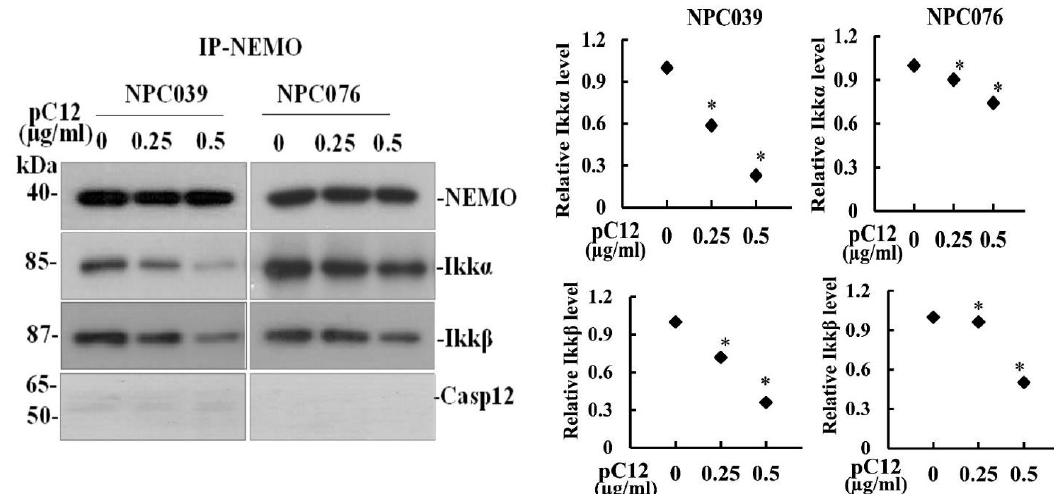
Figure 4. hCasp12 did not physically interact with NEMO. NPC cells were transfected with pC12 for 24 h. The transfected cell lysates were immunoprecipitated with anti-NEMO antibody. The immunoprecipitates underwent western blot analysis with indicated antibodies. The data from three independent experiments are graphed as the mean ± s.e.m., * p < 0.05.